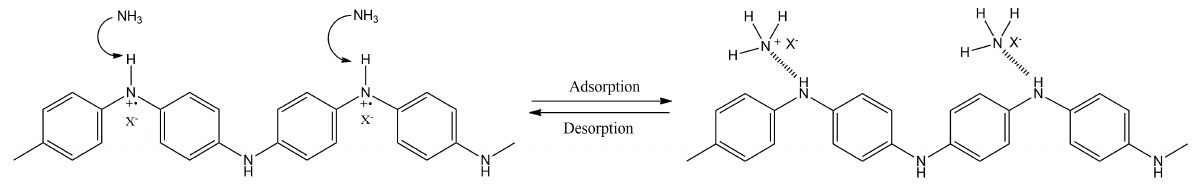
Figure 9. Possible interaction mechanism between ammonia and PANI.